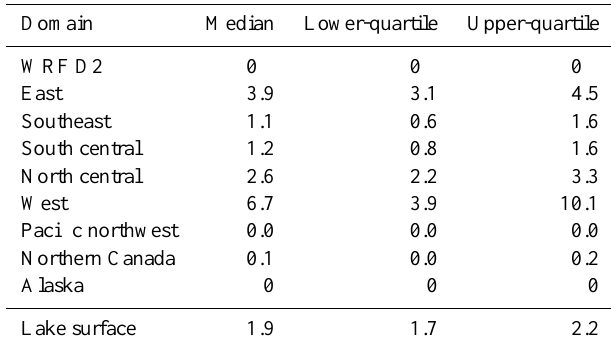
Table 4. Scaling factors for forest fires emissions and lake surface emissions shown in Fig.